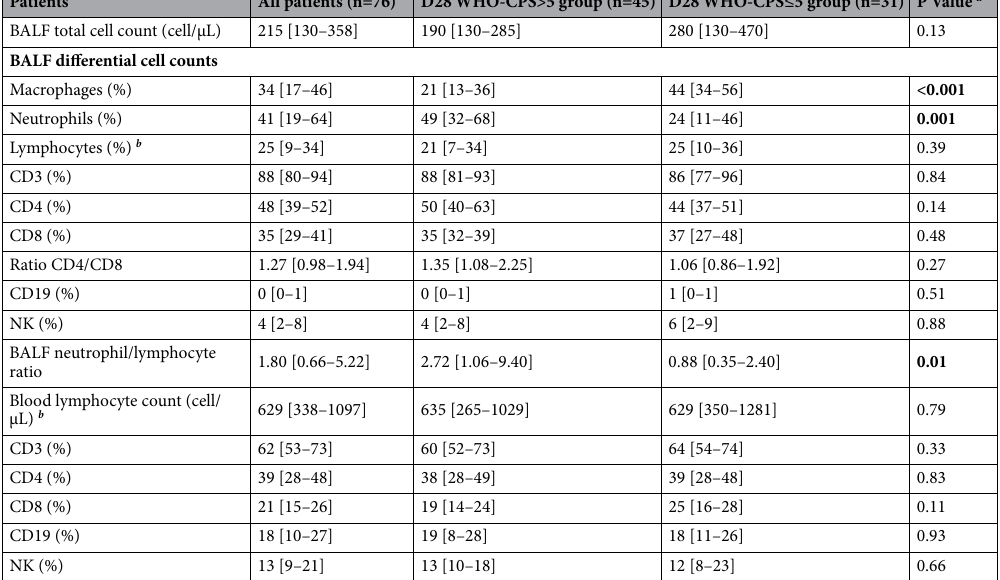
Table 3. Bronchoalveolar lavage fluid and blood cytological analyses in critically ill COVID-19 patients, according to the 28-day WHO-CPS. Data are presented as median [first through third quartiles] or number (%). Patients were grouped according to their WHO-CPS value at 28-day. A score value higher than 5 (D28- WHO-CPS > 5) defined a poor 28-day outcome, whereas a score value equal or lower than 5 (D28-WHO- CPS ≤ 5) defined a good 28-day outcome. BALF bronchoalveolar lavage fluid, ICU intensive care unit. a P values